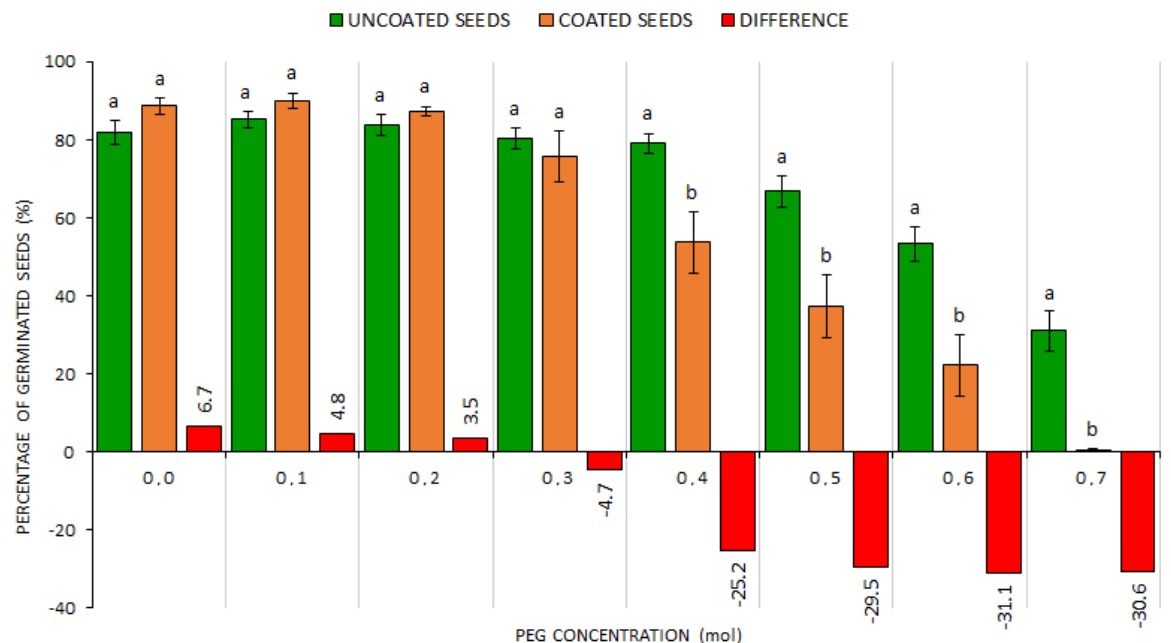
Figure 3. The comparison of germinated seed percentages within US and CS treatments at different drought simulation degrees. Average values for all indicator plants for the US (uncoated seeds; n = 20 ± SE; average of all plant species) and CS (coated seeds; n = 20 ± SE; average of all plant species) treatments with PEG concentrations = 0.0 – 0.7 mol; different lowercase letters indicate significant difference (ANOVA post-hoc Tukey’s HSD test; p < 0.05) for the respective parameters between the US and CS groups.